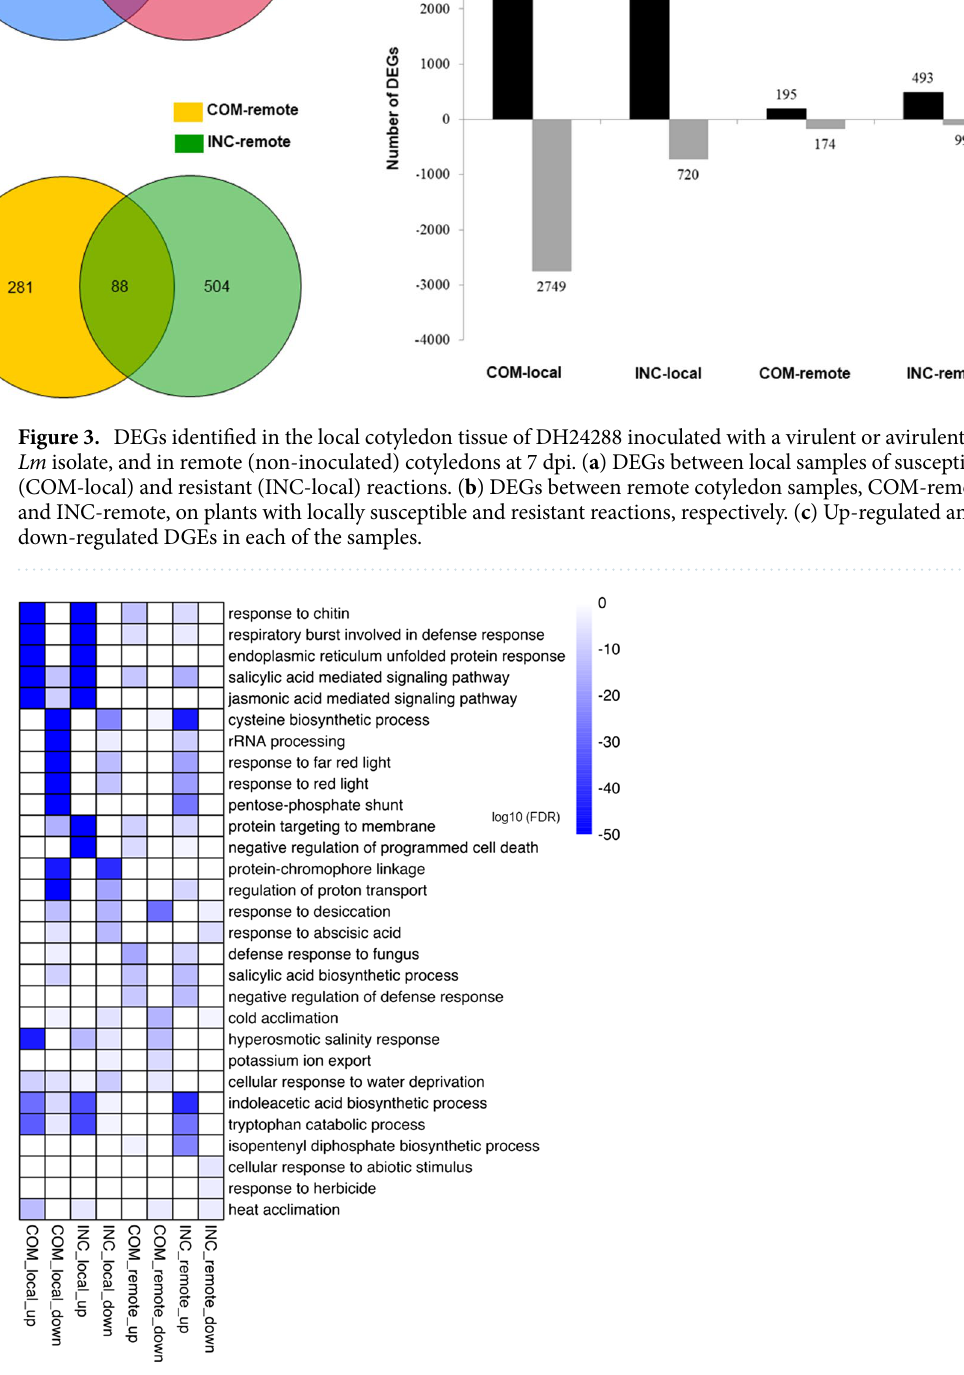
Figure 4. Top five GO terms enriched for the up-regulated and down-regulated DEGs in COM-local, INC- local, COM-remote and INC-remote cotyledon samples. The significance of FDR is associated with colors, from white (high) to blue (low), as defined by the